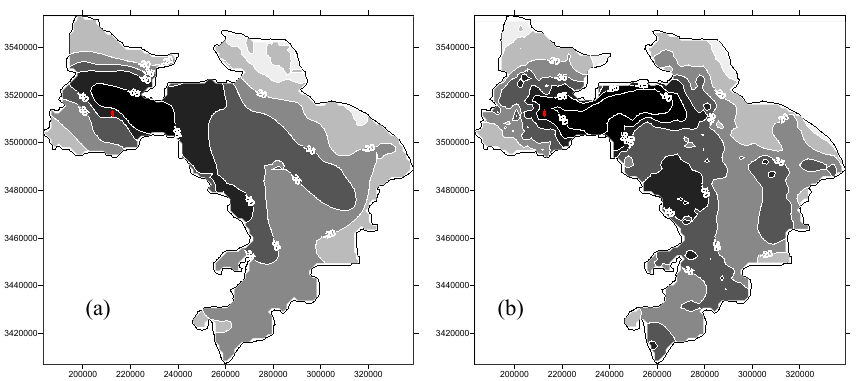
Figure 3. Groundwater level (m above mean sea level) in the second confined aquifer in 1995 (a) and 2001 (b) . The red line represents the earth fissure at Guangming Village.